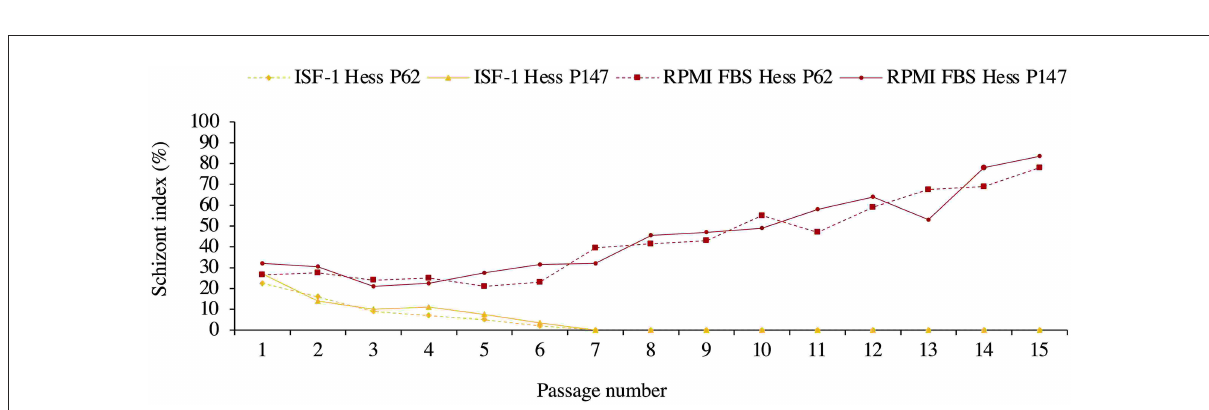
FIGURE3 Schizont index of Hessiene cell culture passage 62 (Hess P62) and passage 147 (Hess P147) cultivated in ISF-1 and RPMI-FBS.